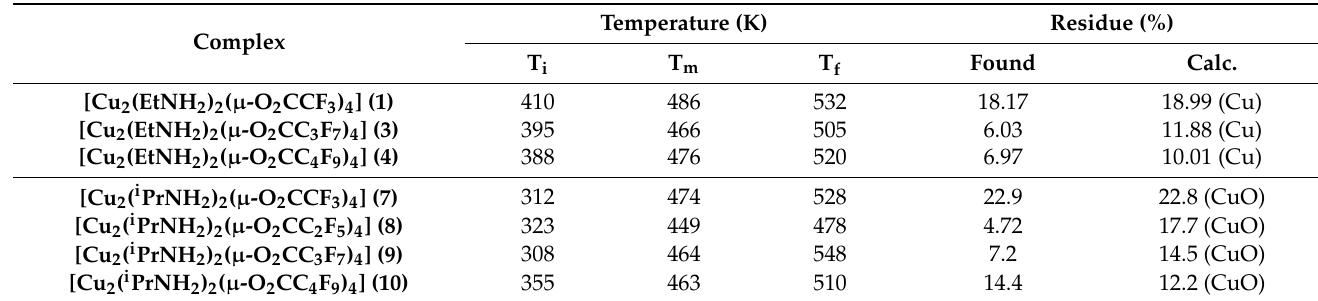
Table 4. Thermal analysis data.